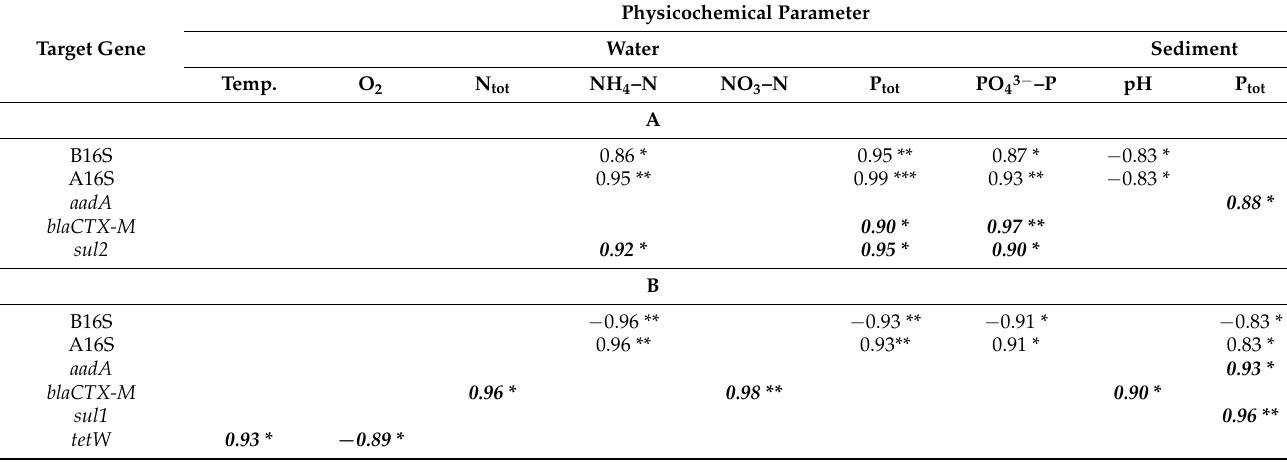
Table 2. Statistically significant Pearson correlations and partial correlations (given in bold italic) between physicochemical parameters and abundances of the target genes ( A ), as well as relative abundances of the target genes in prokaryotic communities ( B ) of the water and sediment samples. In the case of abundances of ARGs, the partial correlations 16S tot were used as covariables, and in the case of relative abundances of ARGs, the relative abundance of bacterial 16S rRNA gene in the total prokaryotic community was used as a covariable. Temp—temperature; N tot —total nitrogen; P tot —total phosphorus; TOC—total organic carbon; B16S—bacteria-specific 16S rRNA gene; A16S—archaea-specific 16S rRNA